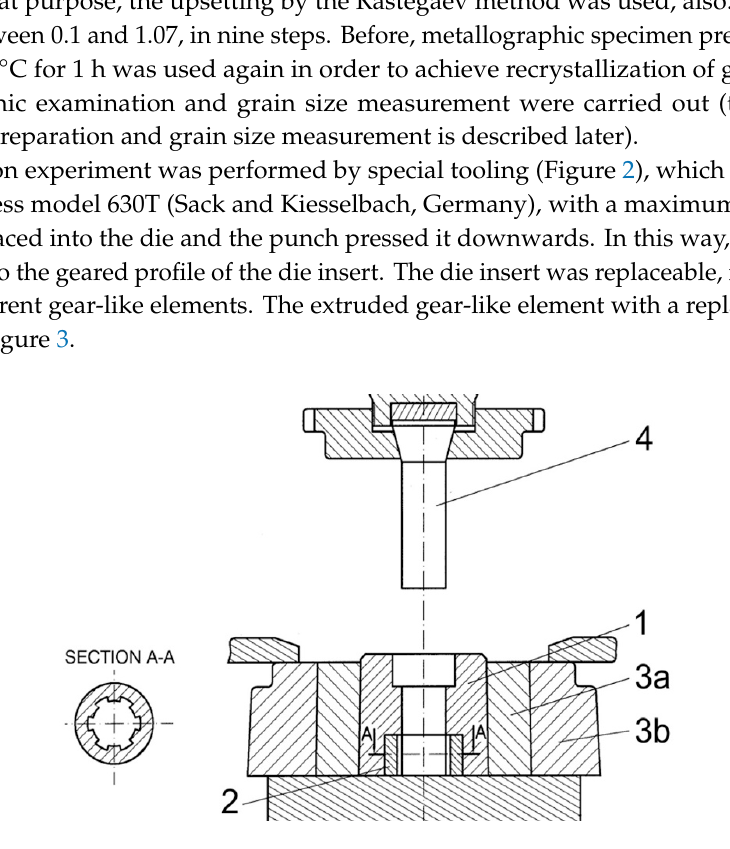
Figure 2. Experimental tooling: 1 die, 2 replaceable die insert, 3a,b inner and outer ring, 4 punch.